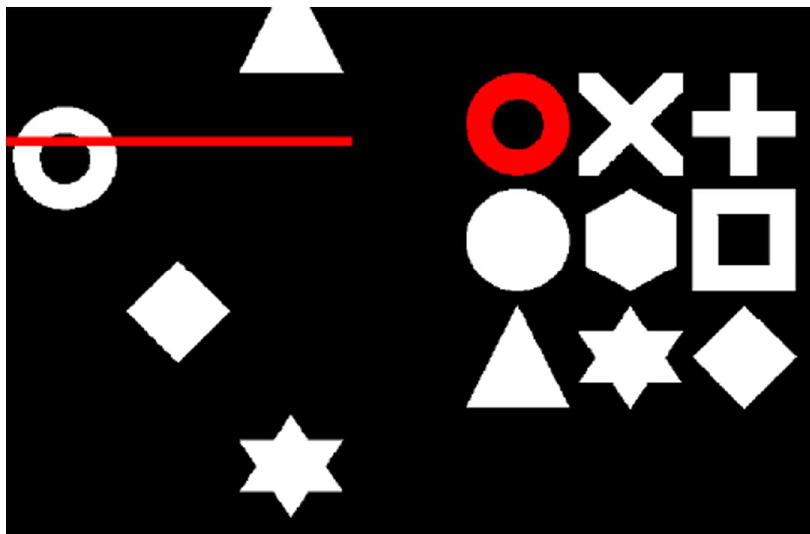
Figure 1. The Swansea Test of Attentional Control (STAC) task. A target is identified within the 3 × 3 matrix of symbols (right). When a matching symbol appears amongst the three columns of the search array that scroll up the screen (left), participants press the spacebar as the symbol crosses behind the red line (as depicted in Hanley and Tales, 2019, [22]).